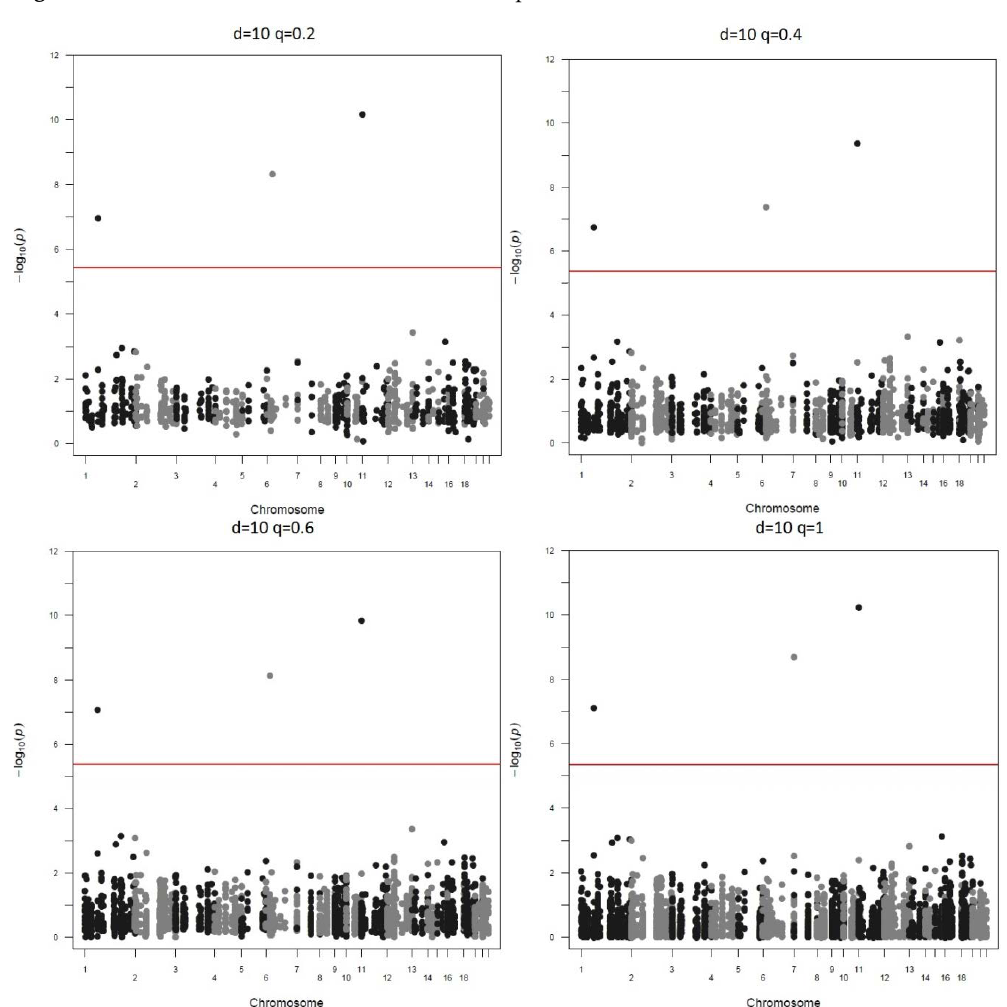
Figure 4. Real data-based studies when down-sample ratio is